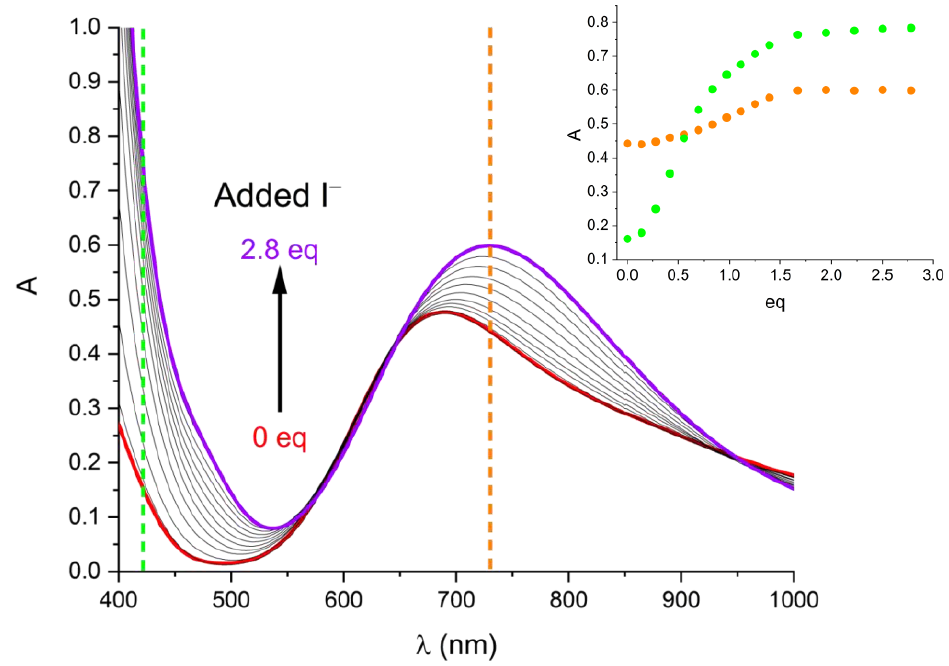
Figure 5. Spectral variation caused by addition of I − equivalents to a 1.44 mM solution of [Cu(L)] 2+ . Inset: sigmoidal profiles of spectral changes upon I − addition at selected wavelengths (730 nm, orange, and 420 nm, green).